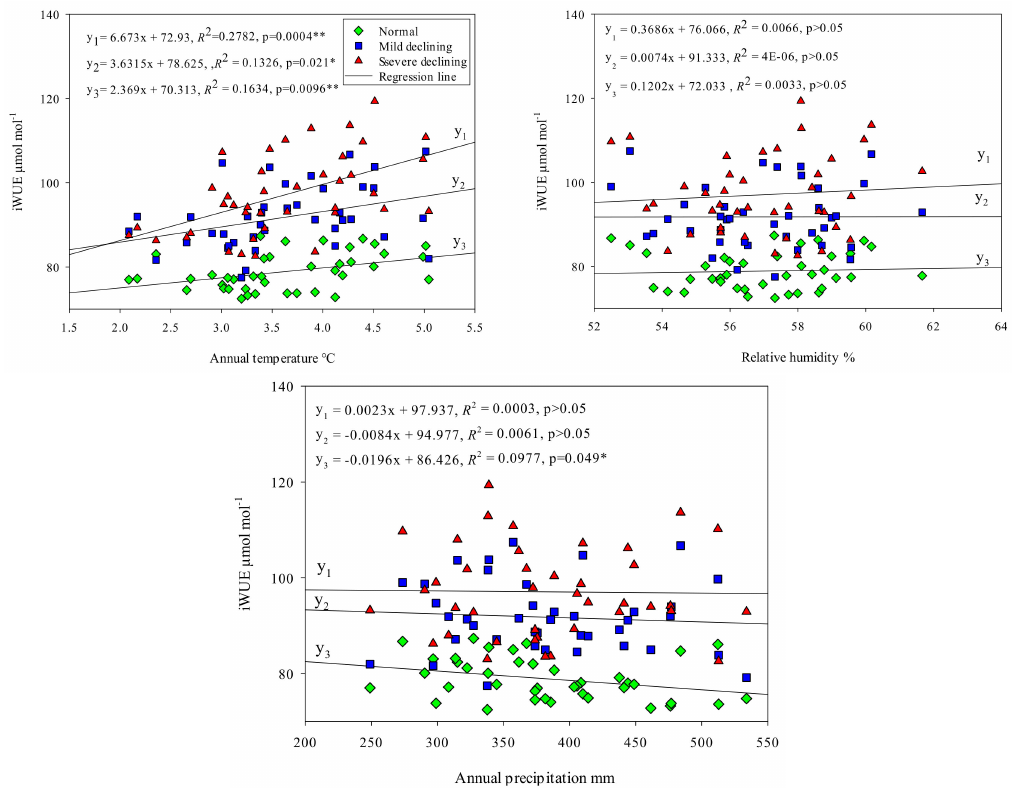
Figure 5. Relationships between iWUE of di ff erent sites and annual temperature (T), relative humidity (RH) and annual precipitation (P). Linear regressions, regression equations and significant levels were shown in figures. “*” means that the linear relationship of regression equation is